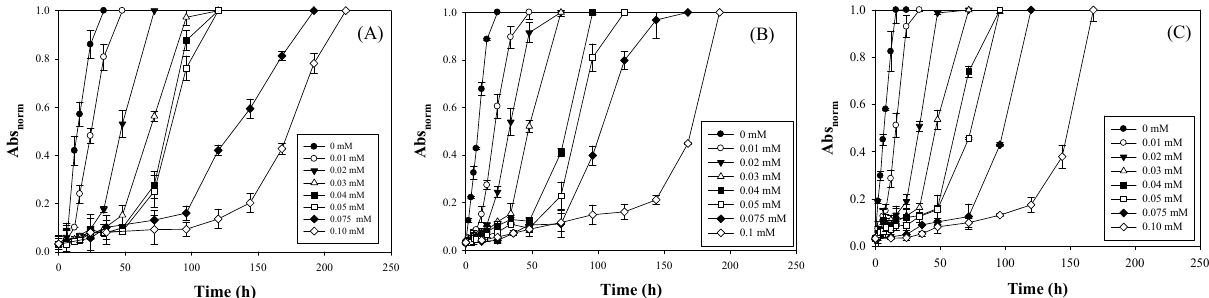
Figure 3. Coloration of TTI prototype containing ( A ) 15, ( B ) 20, and ( C ) 25 µ g/cm 2 of laccase and 0–0.1 mM N-HGG during isothermal storage under 5 °C.